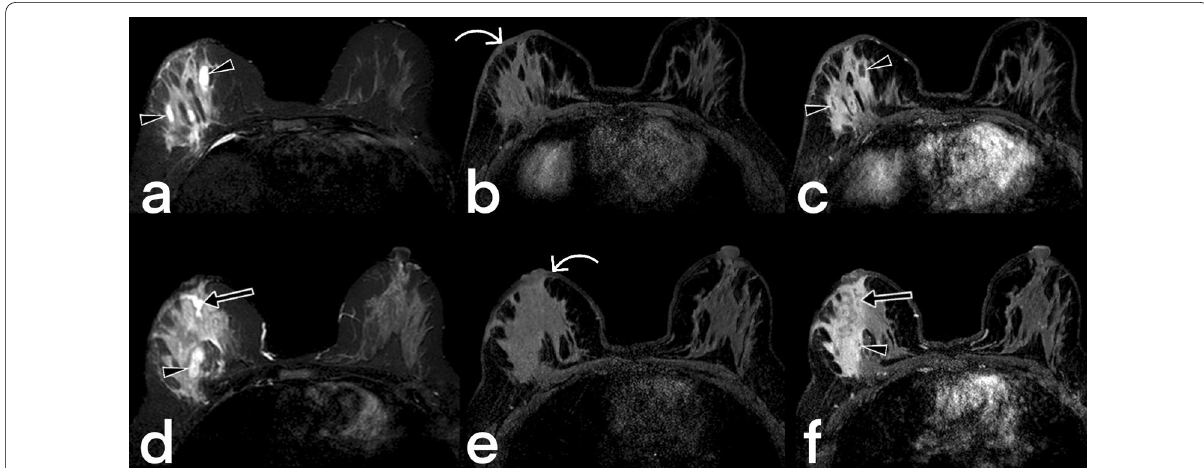
Fig. 21 MR images of a 41-year-old female. Axial T2 weighted ( a , d ), pre-contrast axial T1 weighted ( b , e ), and post-contrast axial T1 weighted ( c , f ) images reveal diffuse increased signal intensity, cystic lesions (arrowheads), ductal ectasia (arrow), and thickened skin (curved arrow) in the right breast. Diffuse-type breast TB